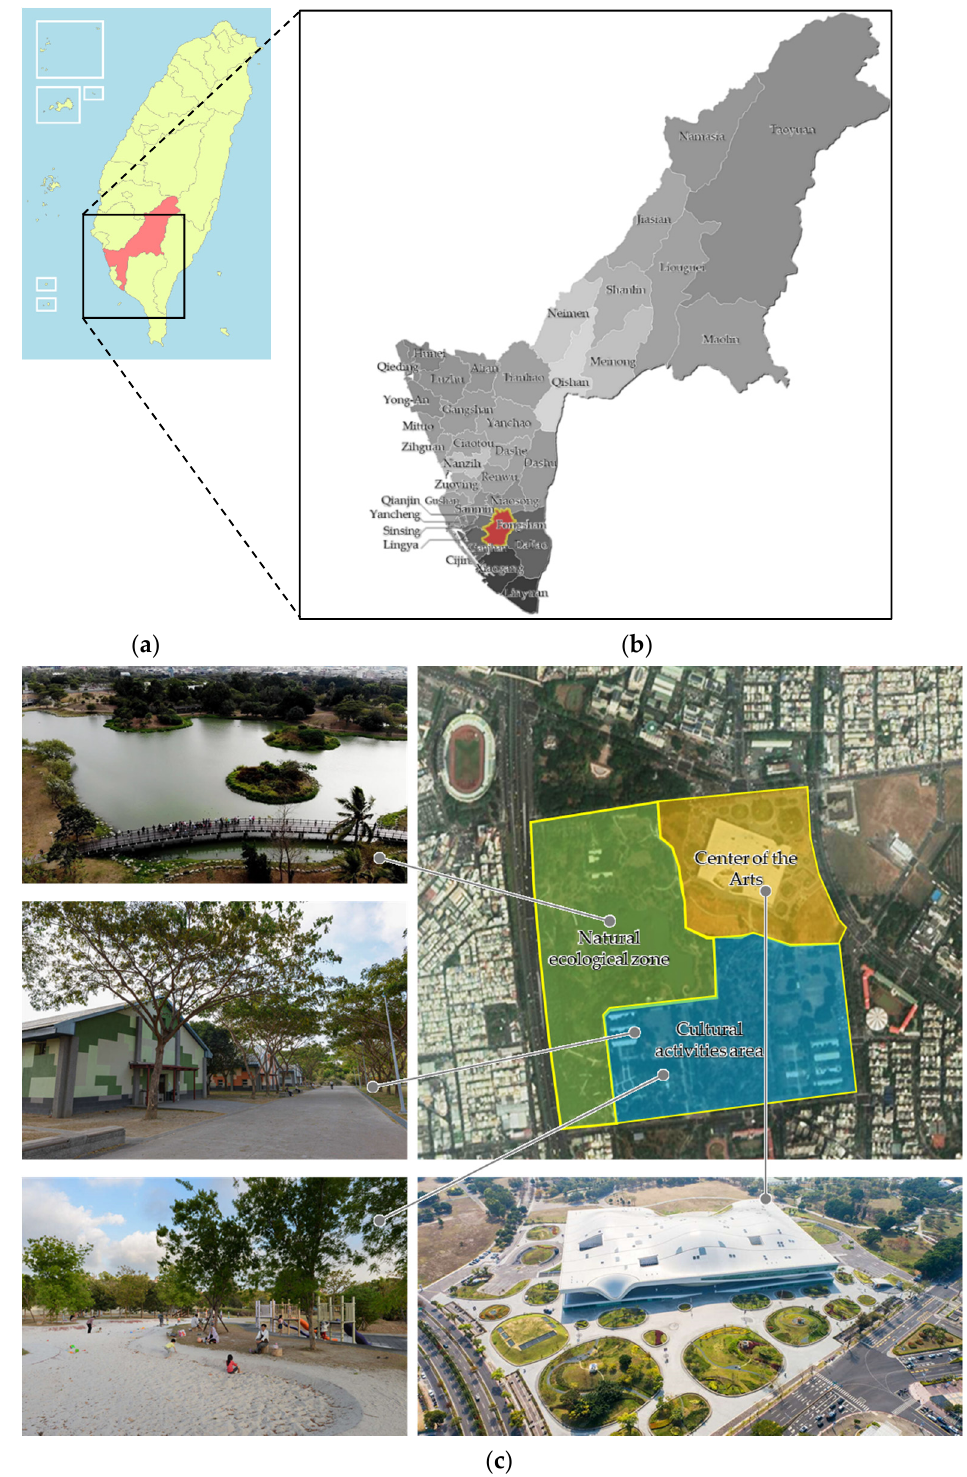
Figure 2. ( a ) Map of Taiwan; ( b ) Map of Gaoxiong; ( c ) Gaoxiong Weiwuying Metropolitan Park.